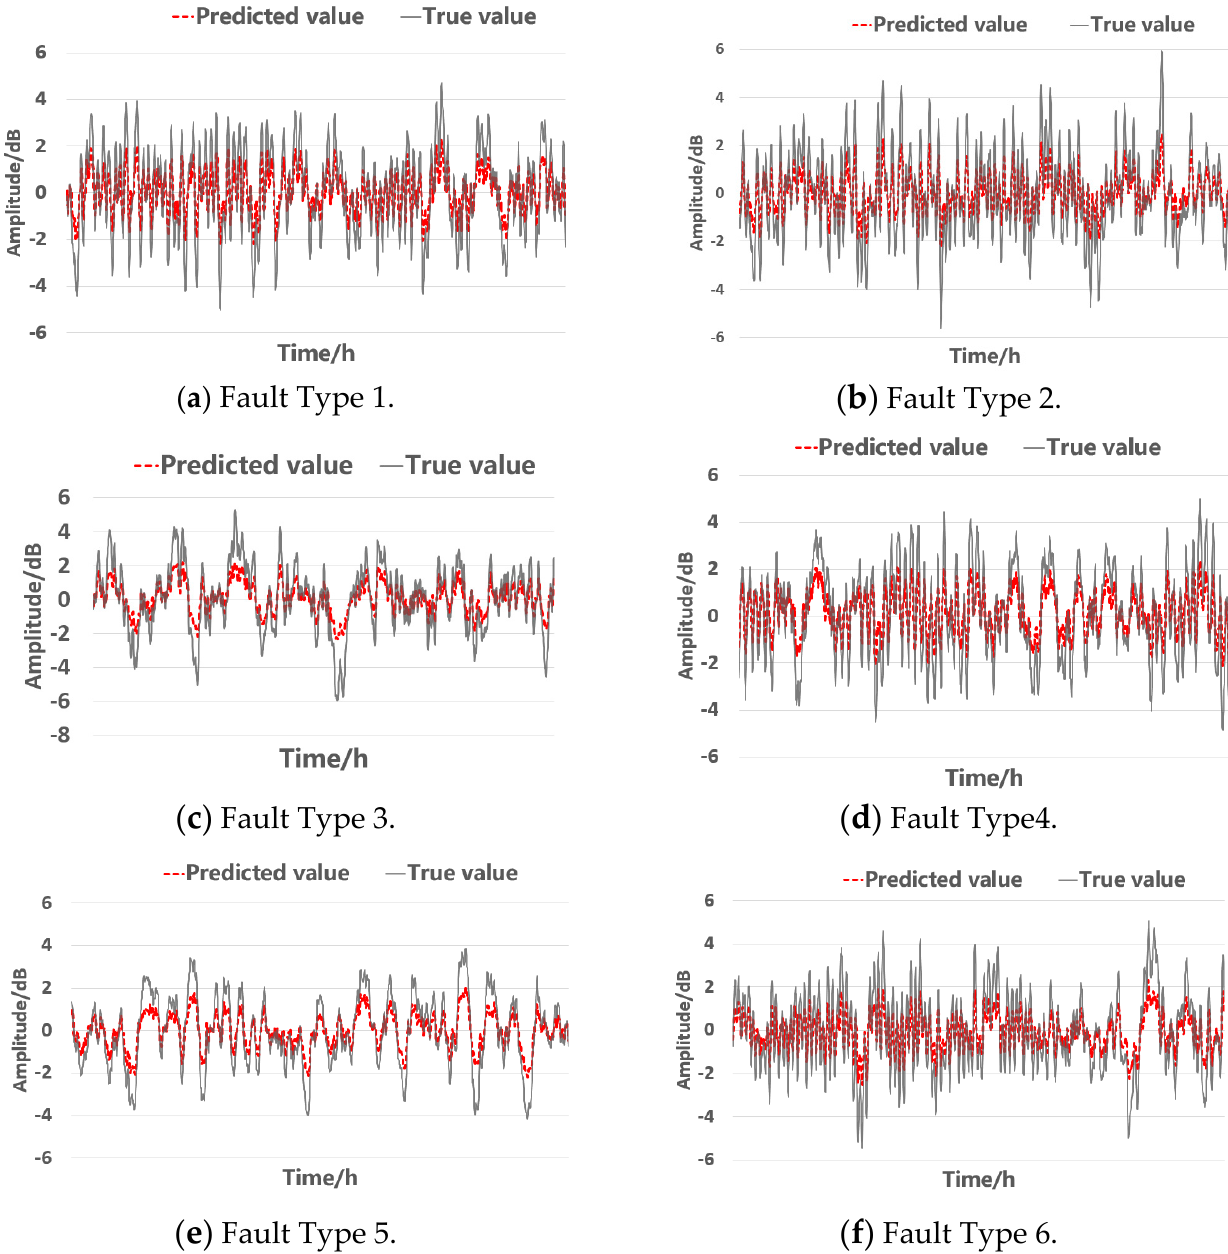
Figure 13. Long time–series fault prediction. Table 1. Fault prediction result evaluation index.